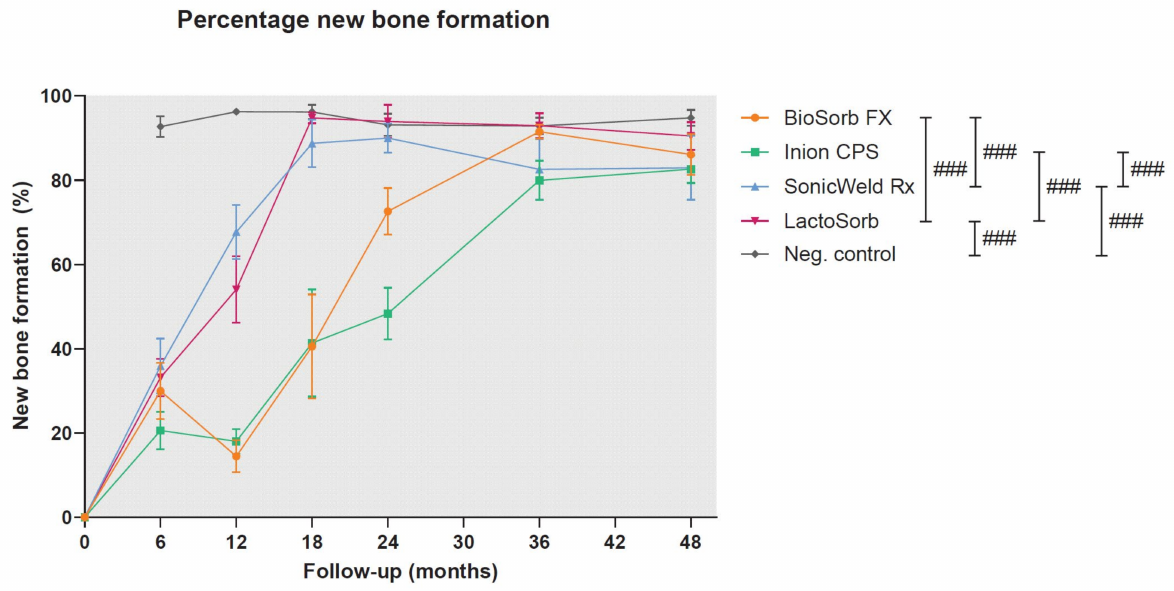
Figure 1. Percentage of total new bone formation at the implant site. Error bars: mean values ± standard error of the mean. ### represents p < 0.05, p < 0.01, and p < 0.001, respectively. The composition of each system is described in Table 1. A similar curve for titanium systems is not applicable due to the non-degradable nature of titanium systems. Error bars: mean values ± standard error of the mean. Reprinted with permission from